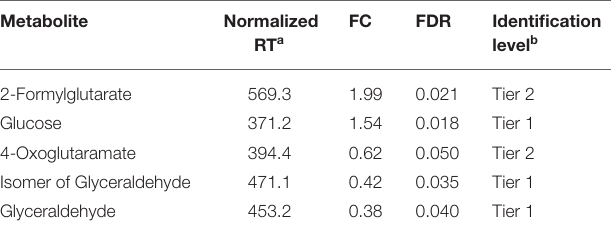
TABLE 2 | Identified carbonyl-containing metabolites affected by cannabidiol (CBD) compared to control (CON).